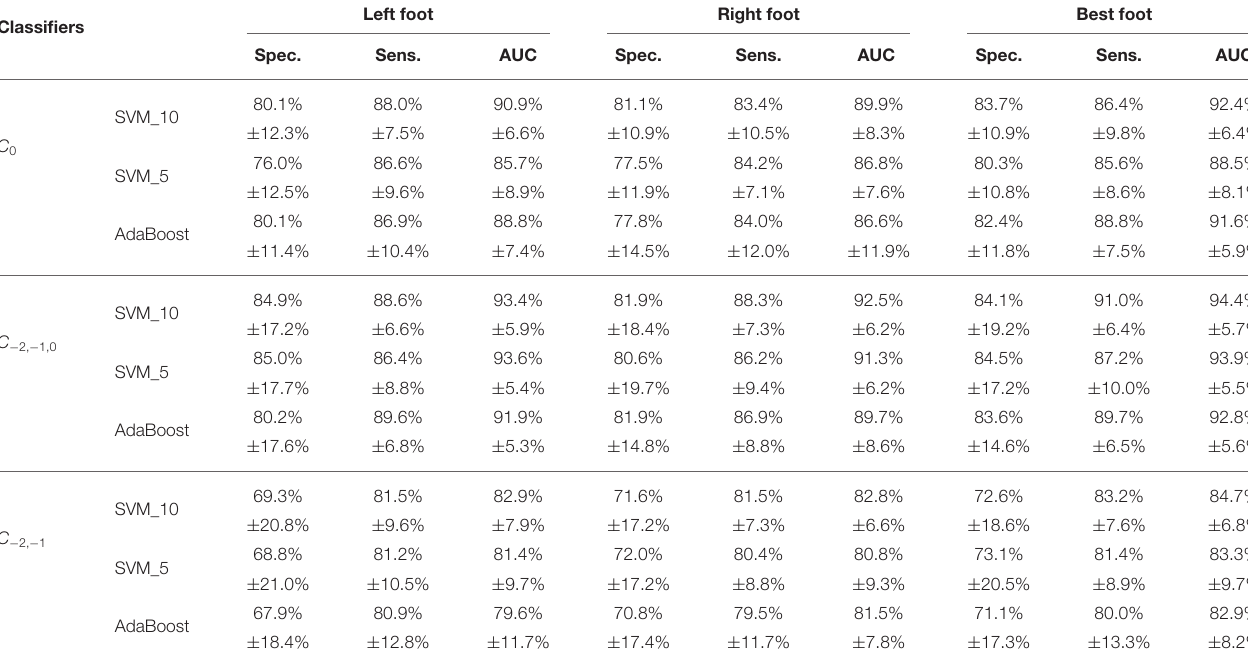
TABLE 8 | Overview of the average results for all classifiers (trained on both feet) using the left foot, right foot, or best foot for validation.